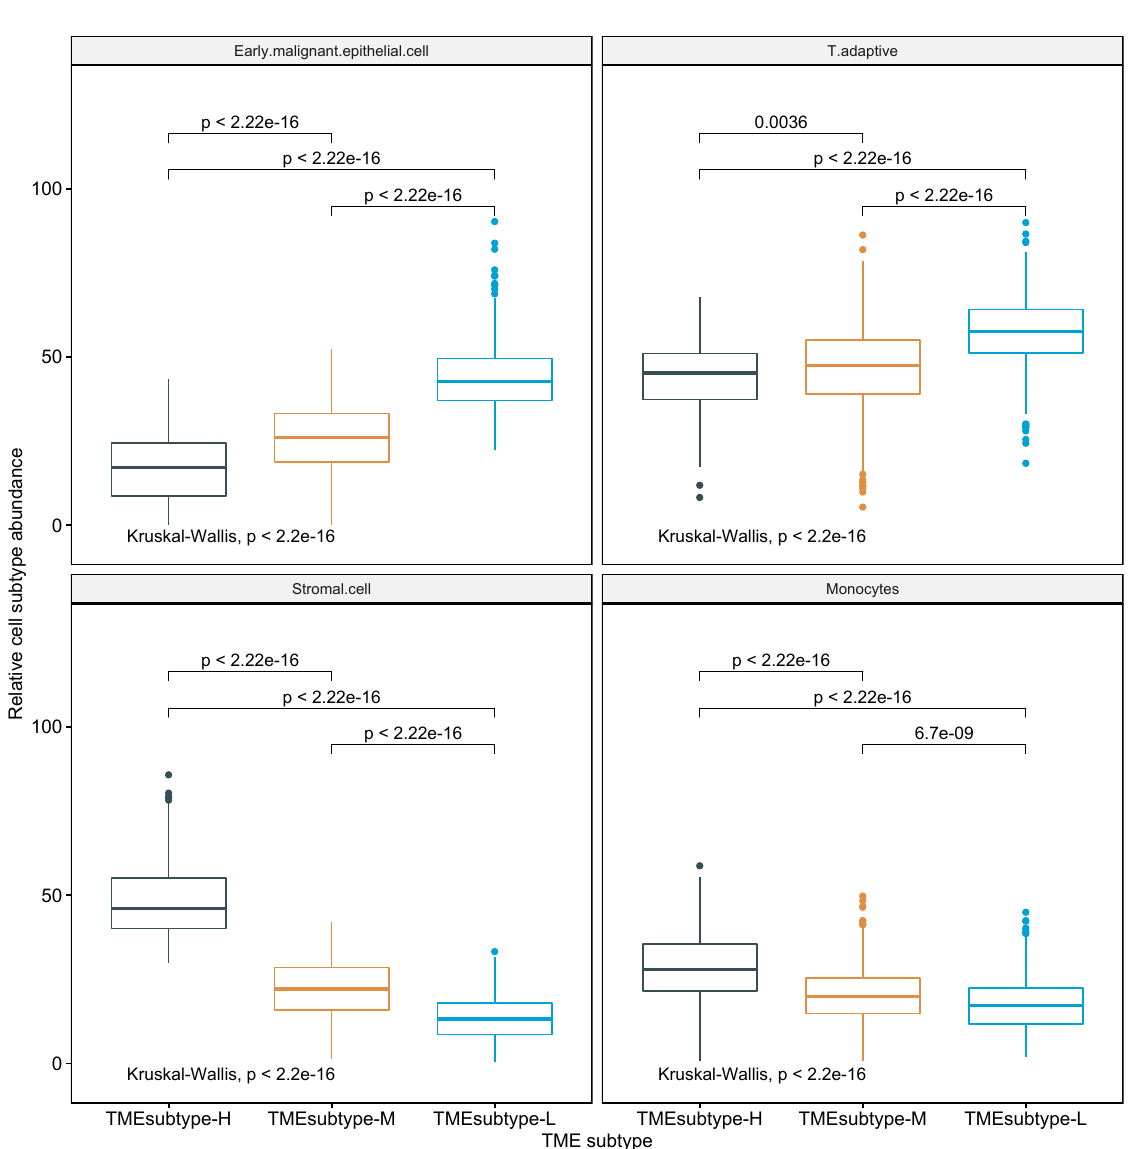
Figure 15. Comparison of the estimated proportions of four prognostic cell populations across three TME subtypes in the meta